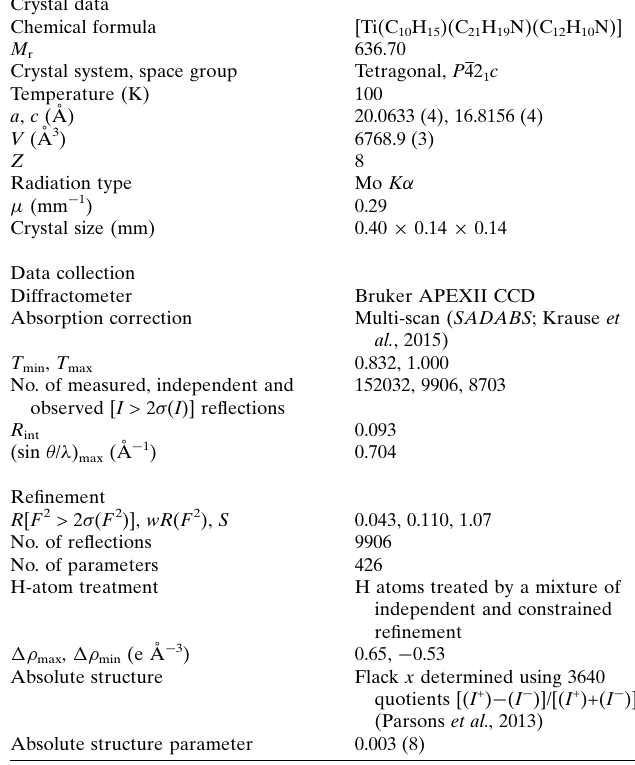
Table 1 Experimental details. Crystal data Chemical